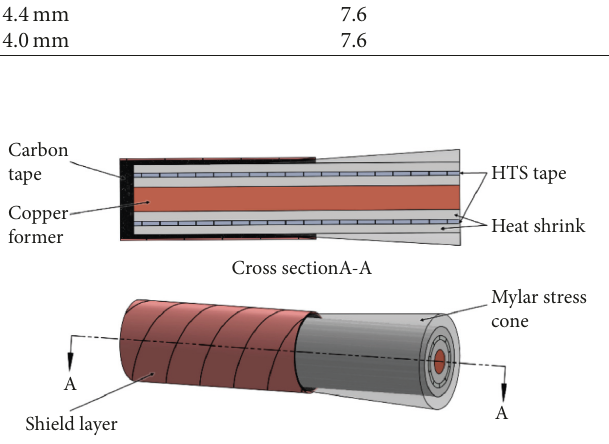
Figure 7: A sketch of one of the cables built for measuring the model cable with heat shrink-insulated tapes (not to scale and pitch angle exaggerated).